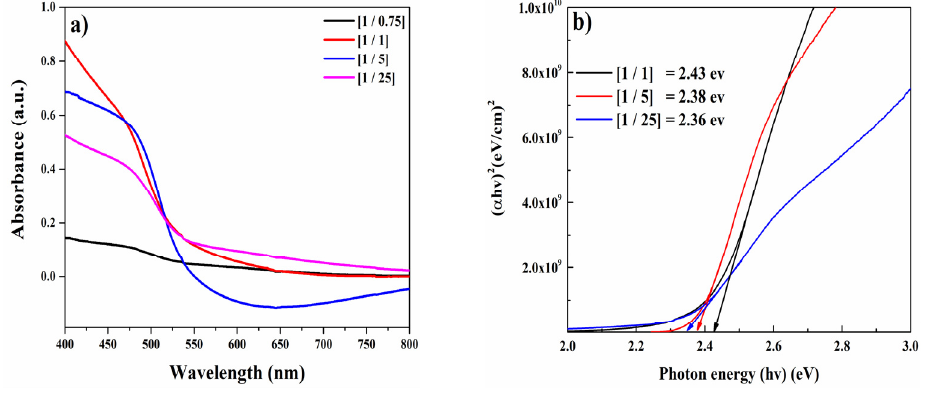
Figure 4. ( a ) Influence of [Cd]/[S] ratio on the absorbance of CdS thin films, ( b ) Difference of ( α h ν ) 2 with photon energy ( h ν ).